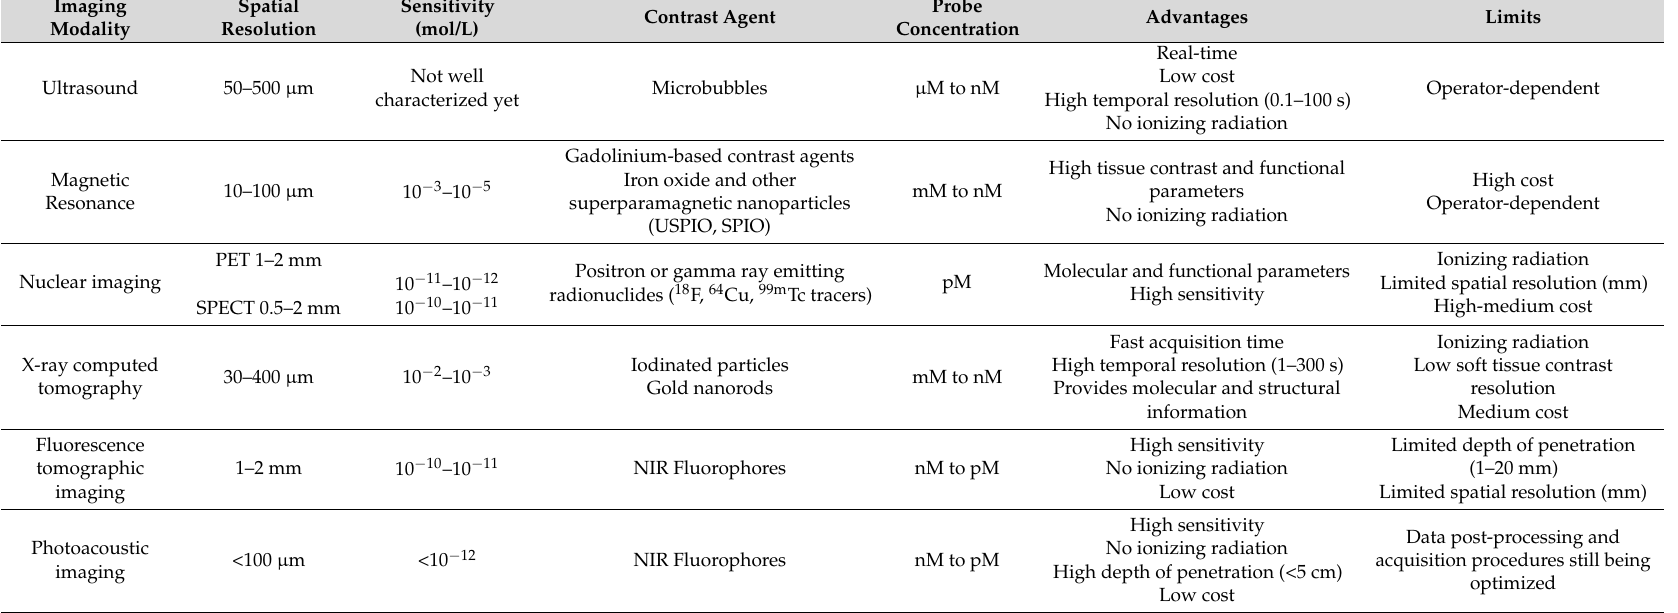
Table 2. Noninvasive molecular imaging in mouse models of vulnerable atherosclerotic